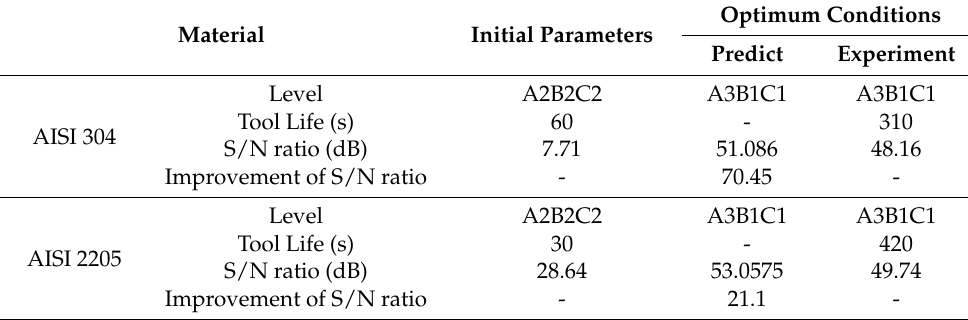
Table 11. Results of the confirmation experiment for tool life.